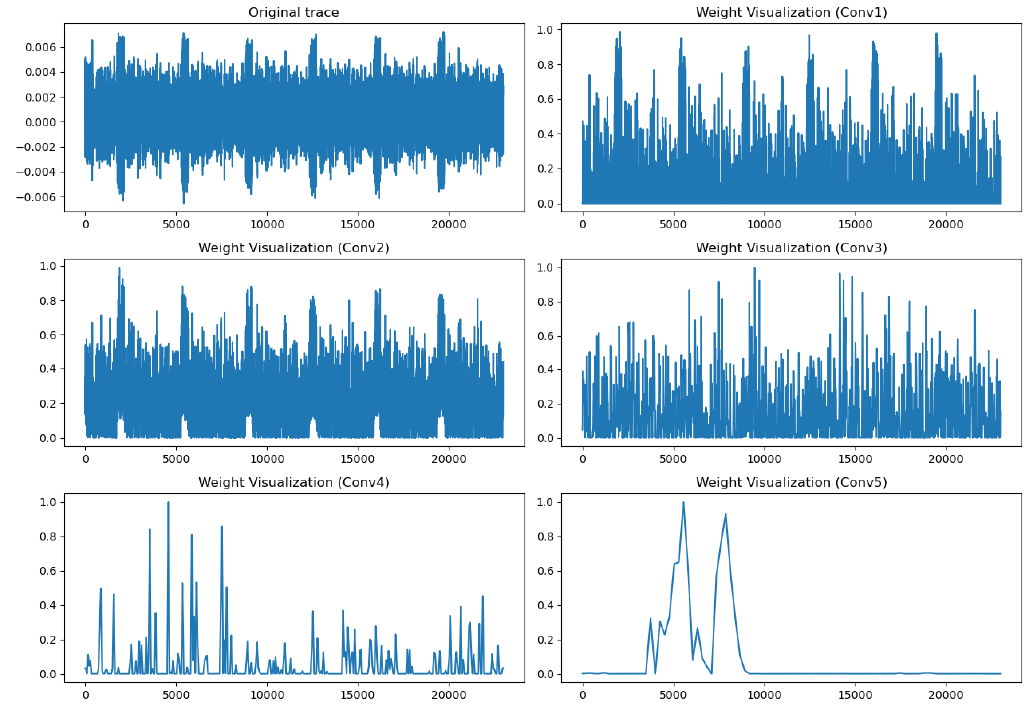
Figure 6. Weight visualization of different convolution